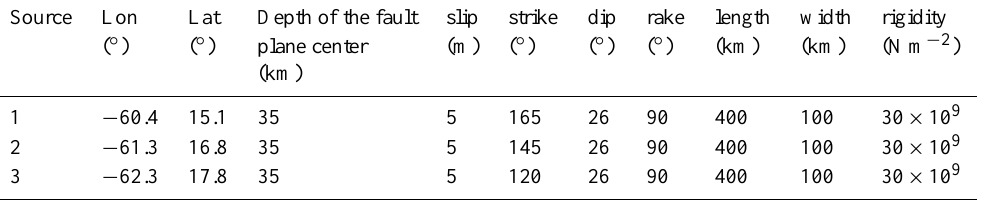
Table 1. Parameters corresponding to the three scenarios of M w ∼ 8 . 4 earthquakes located along the Lesser Antilles subduction zone.